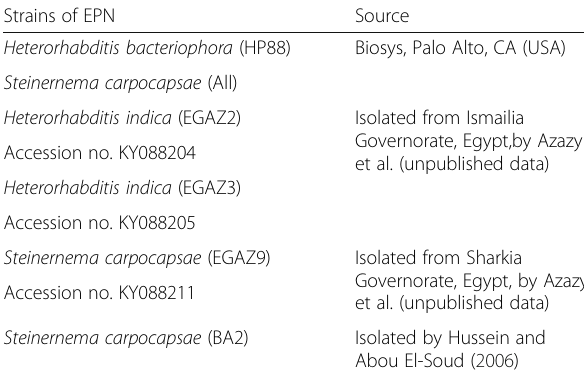
Table 1 Six entomopathogenic nematode isolates (EPNs) tested to control Thrips tabaci in field